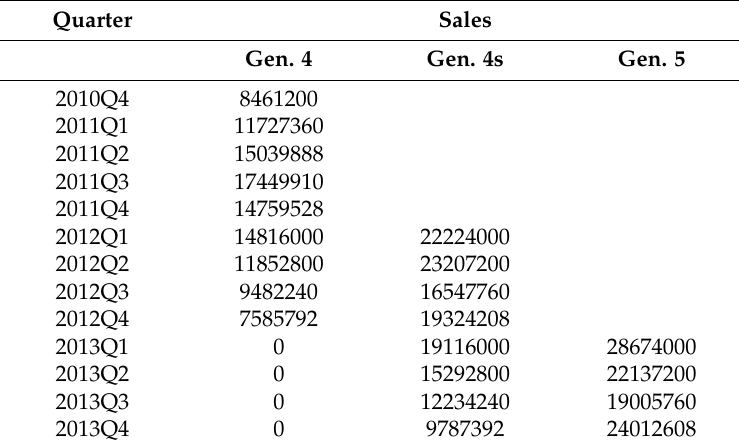
Table 1. Sales data for Apple iPhones belonging to different